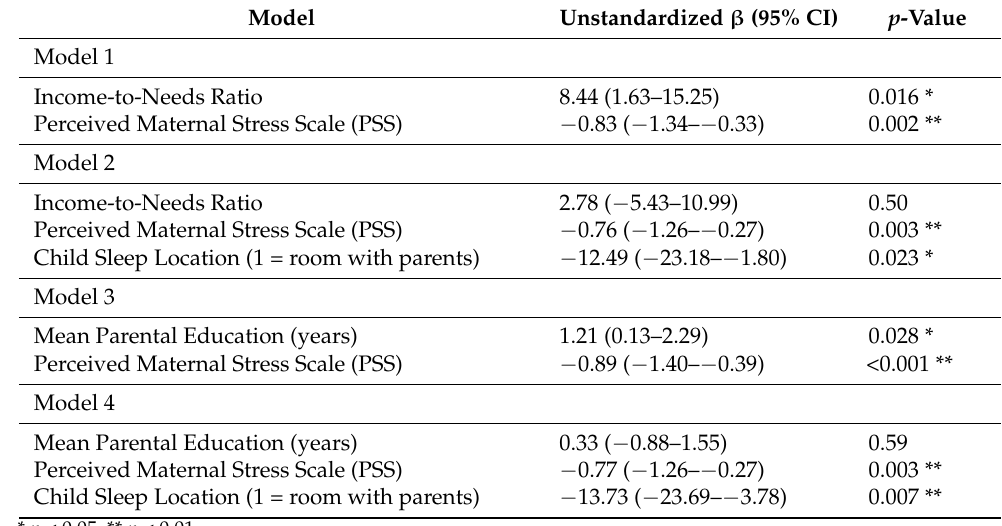
Table 2. Multivariate Linear Regression Results Predicting Modified Infant Sleep Quality